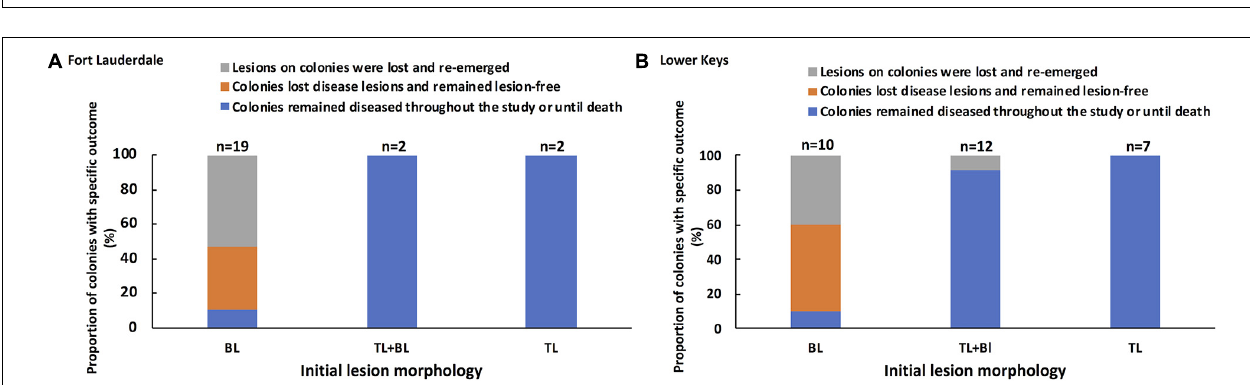
FIGURE 7 | Proportion of tagged M. cavernosa displaying different types of lesion morphologies in year one ( n = 23) and year two ( n = 20) in Fort Lauderdale (A) and in year one ( n = 17) and year two ( n = 14) in the Lower Keys (B) .